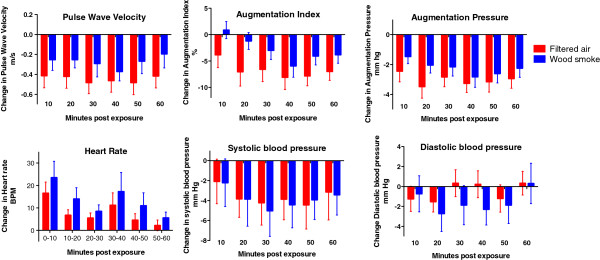
Vascular parameters 10-60 minutes after exposure. Compared to filtered air, wood smoke exposure increased heart rate (p = 0.008), pulse wave velocity (p = 0.005), augmentation index (p < 0.001) and augmentation pressure (p = 0.004), but no effect was seen on brachial systolic (p = 0.858) or diastolic (p = 0.213) blood pressure. All data expressed as mean ± standard error of the mean and P-values from 2-way ANOVA with repeated measures.